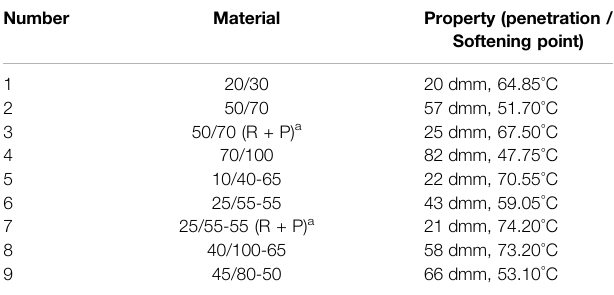
TABLE 1 | Asphalt binders considered for BBR tests and DSR